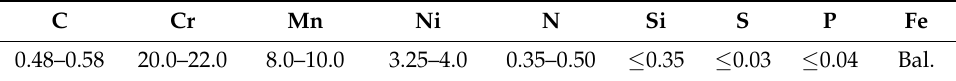
Figure 1. The 21-4N raw material microstructure. Reproduced with permission from [24]. Copyright Elsevier, 2017.